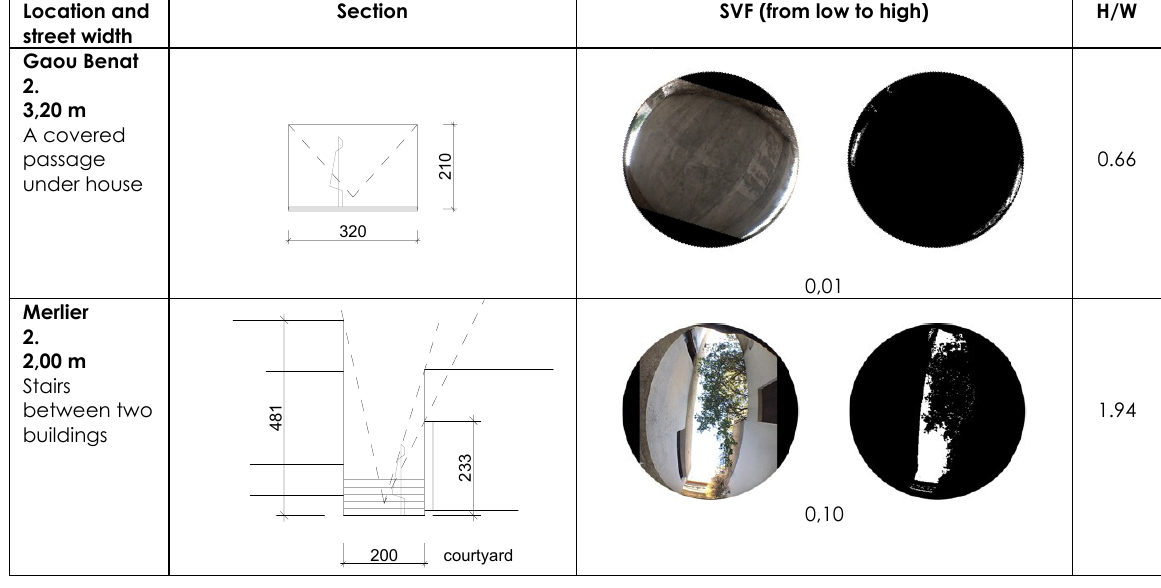
Table 3. A selection of SVF, in increasing order. The fish-eye photographs are in the direction of the street (North up). The dotted line on the sections shows the visible element on the fisheye photograph, which is used for H/W. The first value of the covered passage is not considered for further